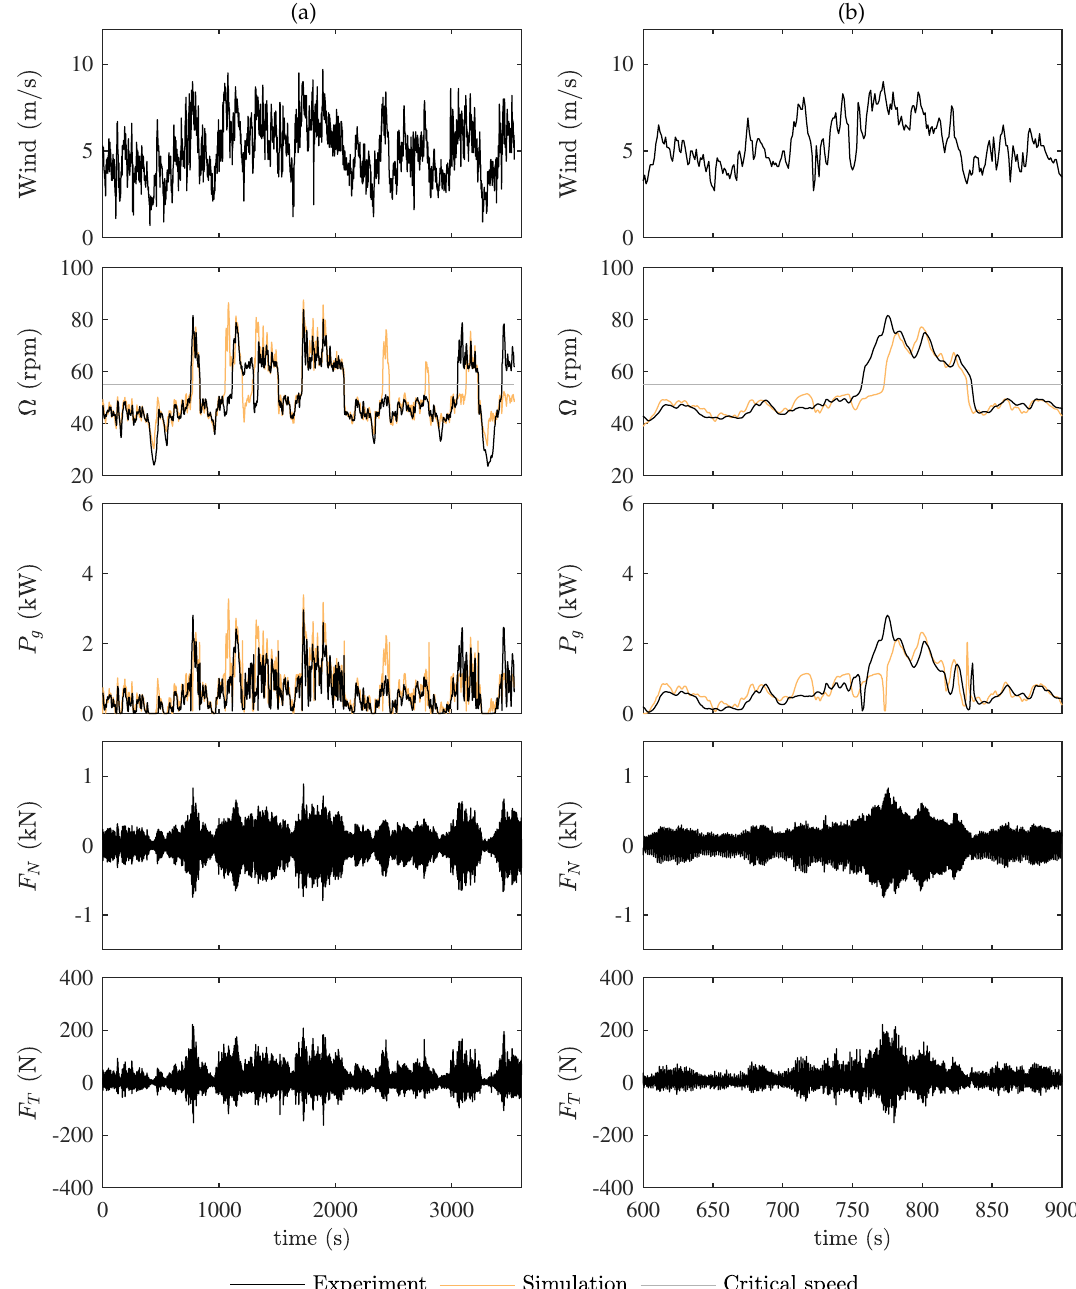
Figure 6. Experimental results and simulation comparison for a critical speed at 55rpm, showing the full 60-min run in ( a ) and a 5-min extraction in ( b